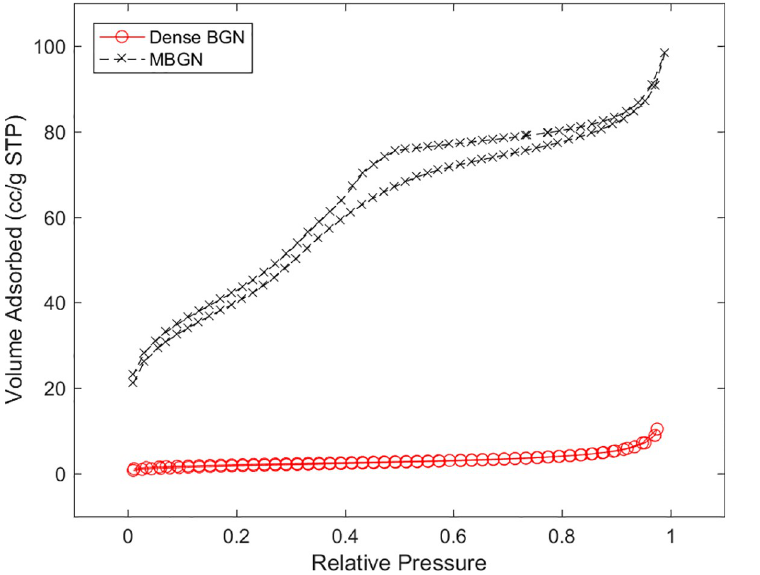
Fig 5. Nitrogen adsorption-desorption isotherms of MBGN and dense